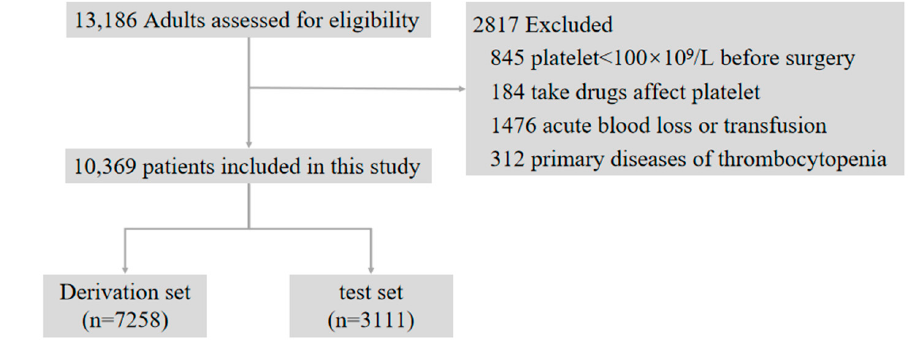
Figure 1. Flow chart of the patients included in this study. Table 1. Cohort